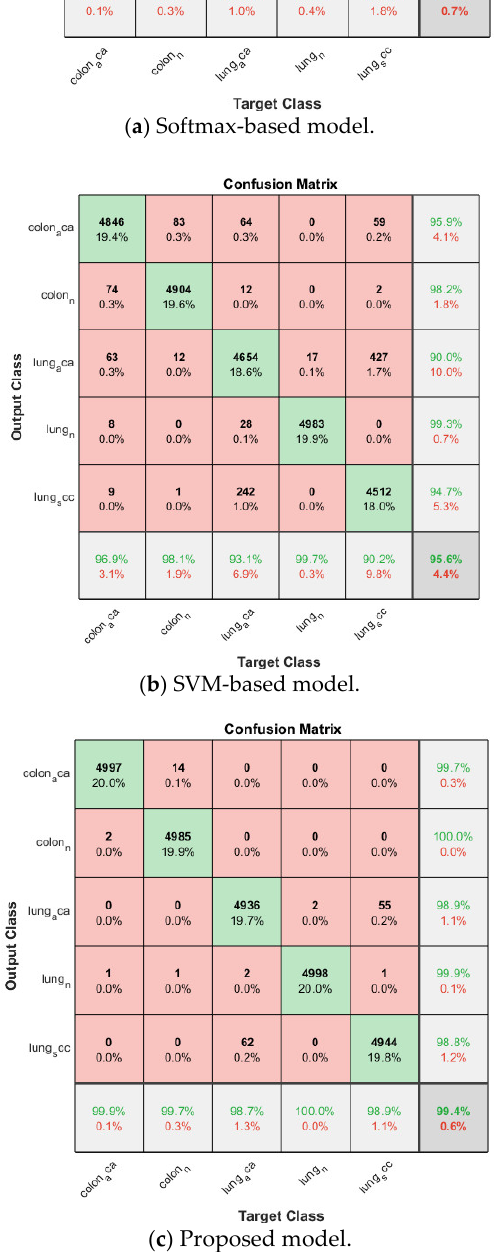
Figure 10. Confusion matrix on lung and colon cancer dataset. Table 2. Cross-validation accuracy of the three transfer learning models on colon and lung cancer dataset.